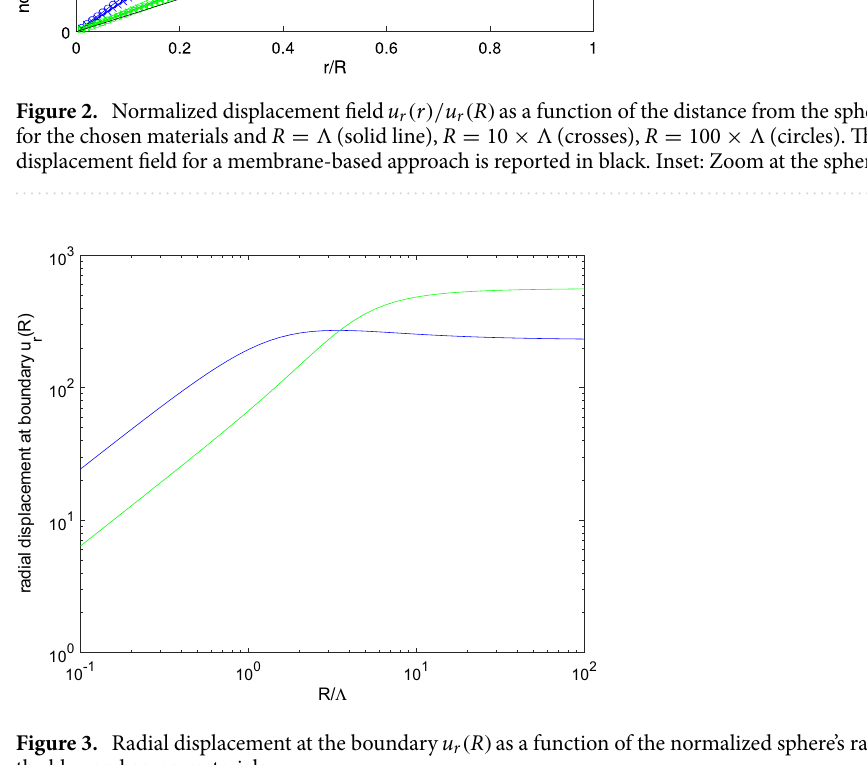
Figure 3. Radial displacement at the boundary u r ( R ) as a function of the normalized sphere’s radius R /� for the blue and green